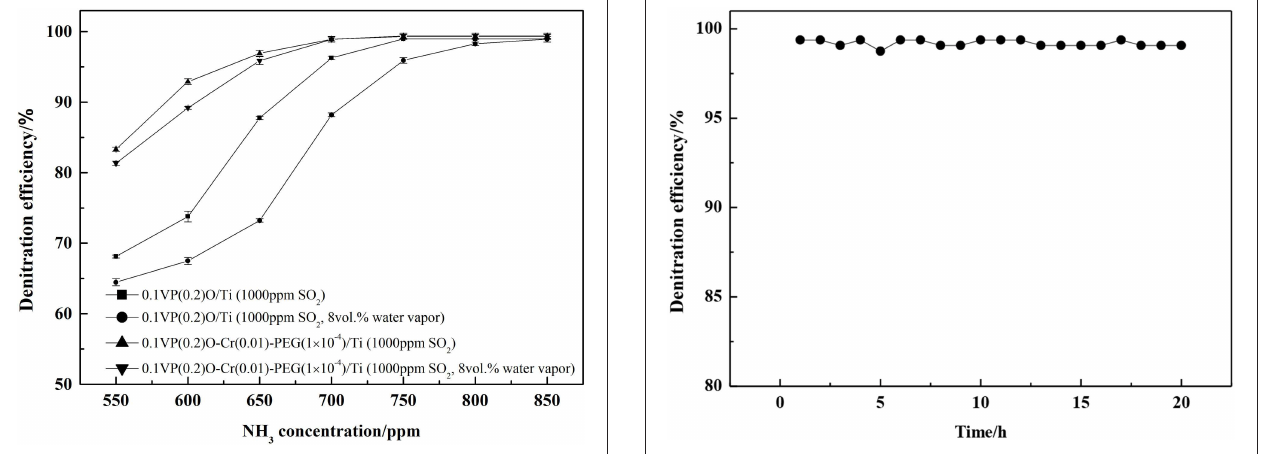
FIGURE 9 | Effect of NH 3 concentration on the denitration efficiency in the presence of SO 2 and water vapor.